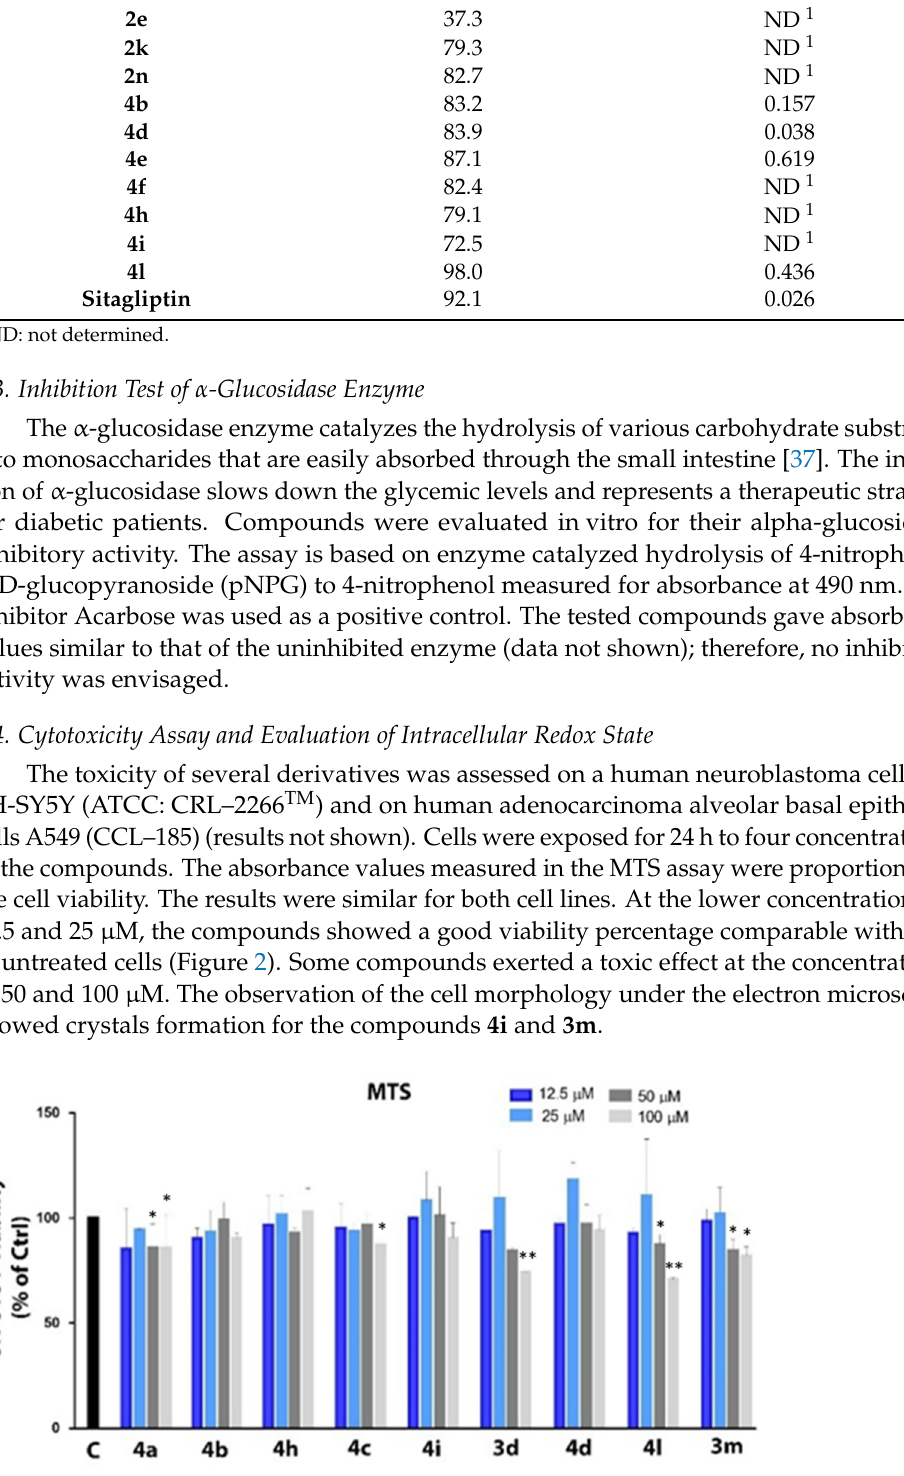
Figure 2. Viability percentage of SH-SY5Y cells exposed for 24 h to serial concentrations of the compounds. Data were compared by one-way ANOVA followed by Dunnett’s multiple-comparison test: *, p < 0.05; **, p < 0.01 as compared to control (C) group. The assay with 2 ′ ,7 ′ -dichlorofluorescin-diacetate (DCFH-DA) was performed to evaluate the effect of the compounds on the intracellular redox potential of SH-SY5Y cells and A549 cells (results not shown). DCFH-DA is a non-fluorescent and cell-permeant molecule used as an indicator for reactive oxygen species (ROS). Inside the cell, the DCFH- DA is hydrolyzed by intracellular esterase with cleavage of the acetate group. In the presence of ROS, the molecule is oxidized to the highly fluorescent 2 ′ ,7 ′ - dichlorofluorescin (DCF). The emitted fluorescence is proportional to the quantity of the intracellular ROS. The treated cells gave fluorescence values similar to the untreated cells (C) (Figure 3). This result suggests that the tested compounds do not stimulate ROS production and, therefore, do not give oxidative stress.